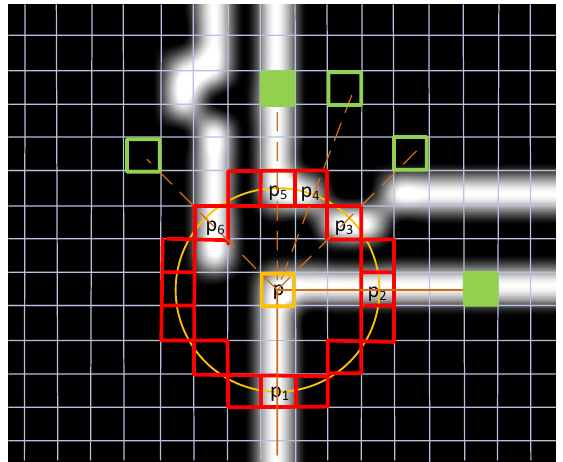
Figure 6. The principle of L-FAST algorithm to extract corners.